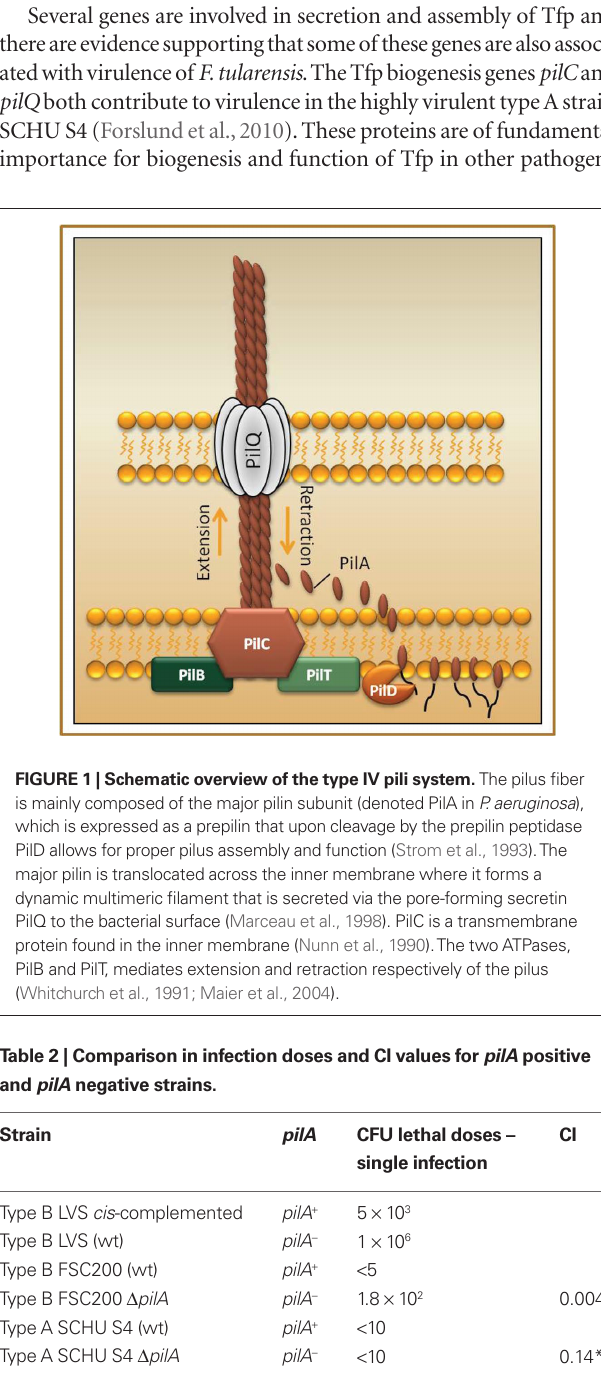
*Competitive index (CI) is the ratio between the pilA mutant and the isogenic wildtype strain for bacteria isolated from spleens of mice simultaneously infected with the two